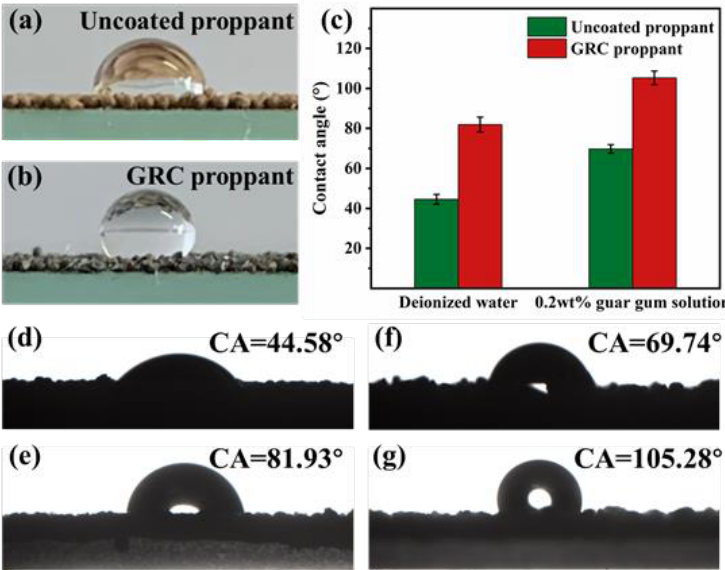
Figure 4. ( a , b ) Photographs of 0.2 wt% guar gum solution on the surface of uncoated proppants and GRC proppants. ( c ) Histogram of the contact angle between proppants and liquid. ( d ) The contact angle of uncoated proppants and deionized water. ( e ) The contact angle of GRC proppants and deionized water. ( f ) The contact angle of uncoated proppants and 0.2 wt% guar gum solution. ( g ) The contact angle of GRC proppants and 0.2 wt% guar gum solution.